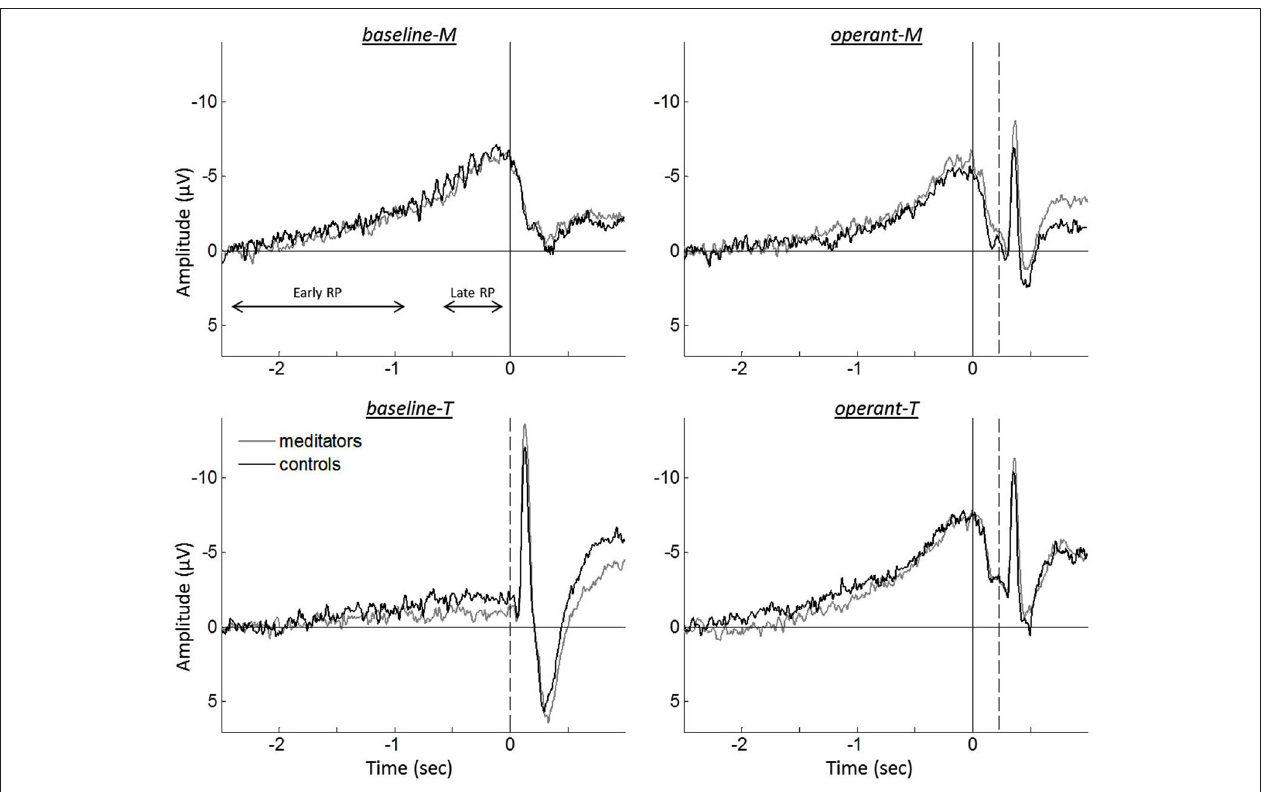
movement, while dashed vertical lines indicate the tone onset. The division for the early RP and the late RP are represented by both-sided arrows.